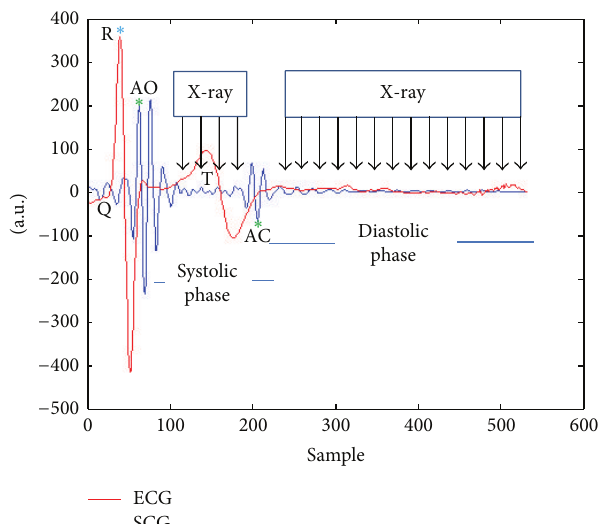
Figure 12: Tighter padding intervals for prospective ECG